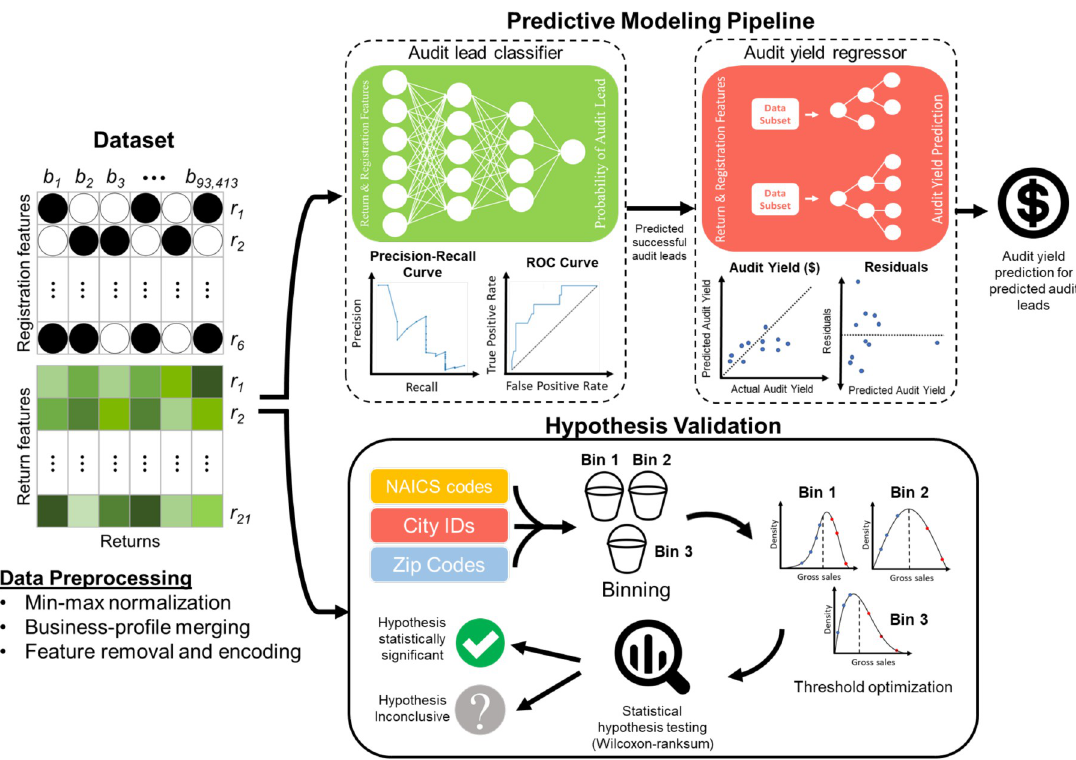
Fig 1. Overview of tax prediction pipeline–raw data received from the CDTFA is first preprocessed via normalization, merging of business profiles and feature removal to create a compendium of tax audit data based on registration and return features. This complete dataset then undergoes one of two steps: One, data is fed through a predictive modeling pipeline in which a feed-forward neural network first classifies an audit as positive or negative, and then second a series of extreme gradient boosted trees are used to predict audit yield based on these positive audits. Two, data is binned based on city and NAICS codes such that hypotheses generated by the CDTFA team can be tested and validated statistically.